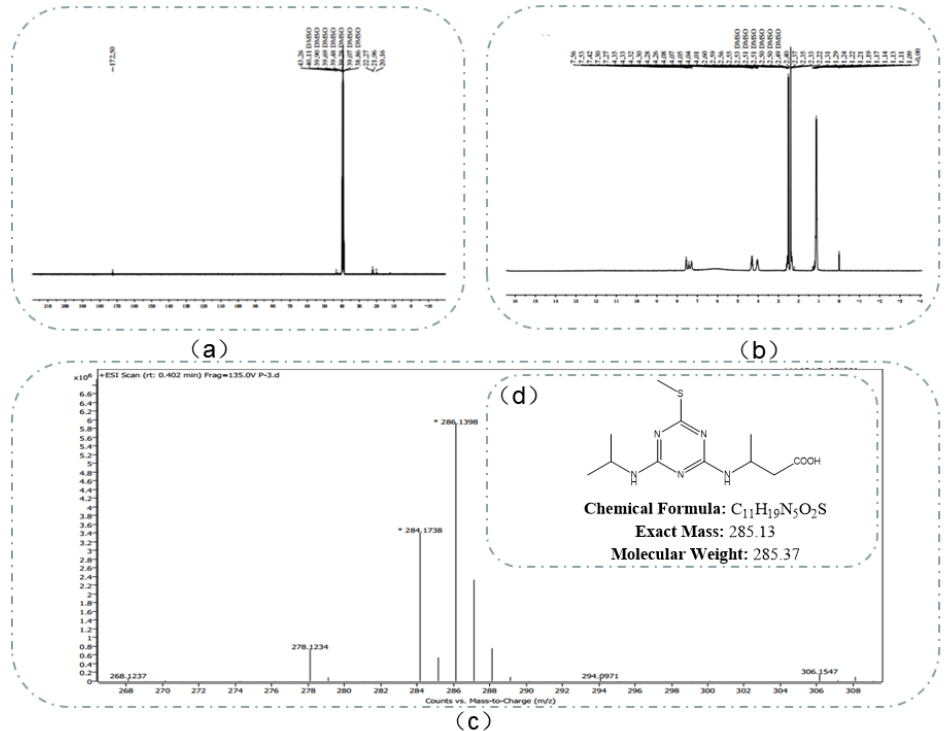
Figure 2. Identification of hapten using 13 C NMR ( a ), 1 H NMR ( b ), HRMS ( c ) analyses, and chemical structural formula ( d ).